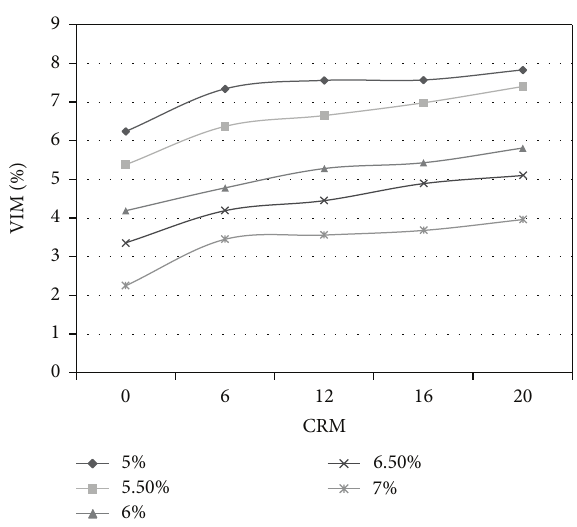
Figure 9: Resilient modulus versus Bitumen content.